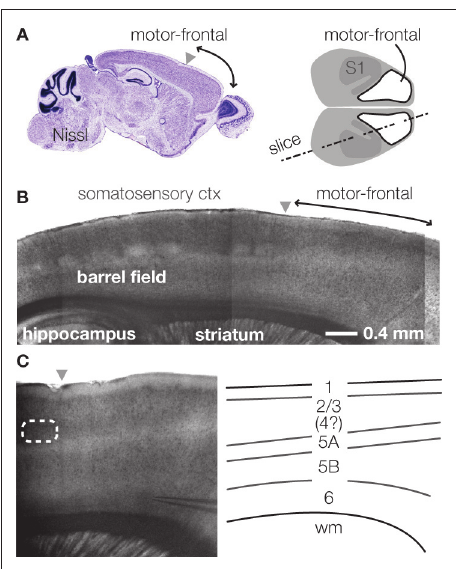
Figure 1 | Layers in the mouse’s agranular cortex. (A) Sagittal section through the mouse’s motor-frontal cortex (left). Source: Allen Brain Atlas’ reference atlas (mouse.brain-map.org). Schematic top view of mouse cortex, showing location of motor-frontal area (right). (B) Bright-field image of slice (slice angle indicated in (A) , right). Anterior is to the right. The agranular motor-frontal cortex lacks the distinct layer 4 barrels seen in somatosensory cortex. (C) Laminar labeling scheme in mouse motor-frontal cortex. Bright-field image of motor-frontal cortex slice (left). Schematic (right) indicates the major